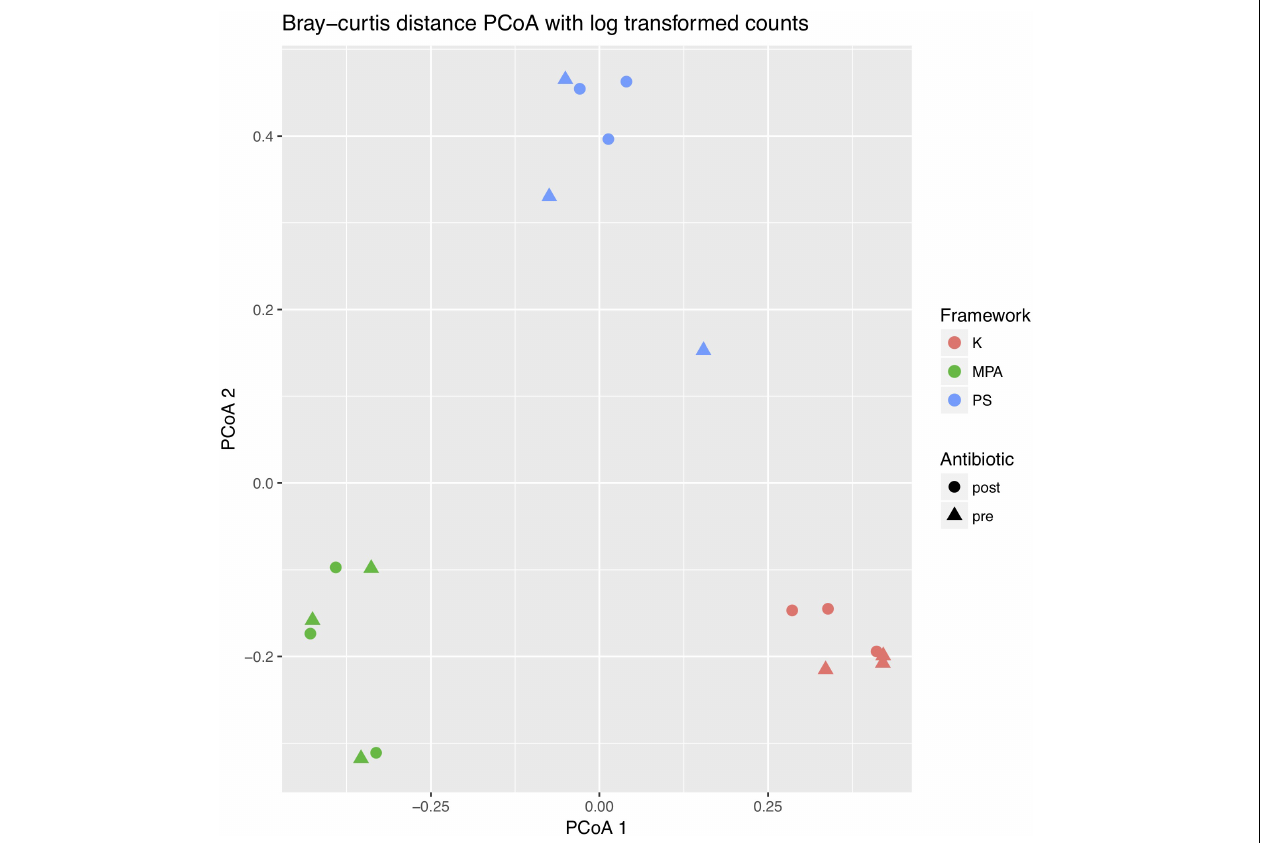
FIGURE 2 | Two-dimensional principle coordinates analysis (PCoA) plot of pre- and post-antibiotic samples analyzed across computational frameworks. The PCoA was created using Bray–Curtis distance matrices with log transformed counts. Differences in sample types are shown by different shapes, while differences in computational framework are shown by different colors. K, Kraken, MPA, MetaPhlAn, PS,